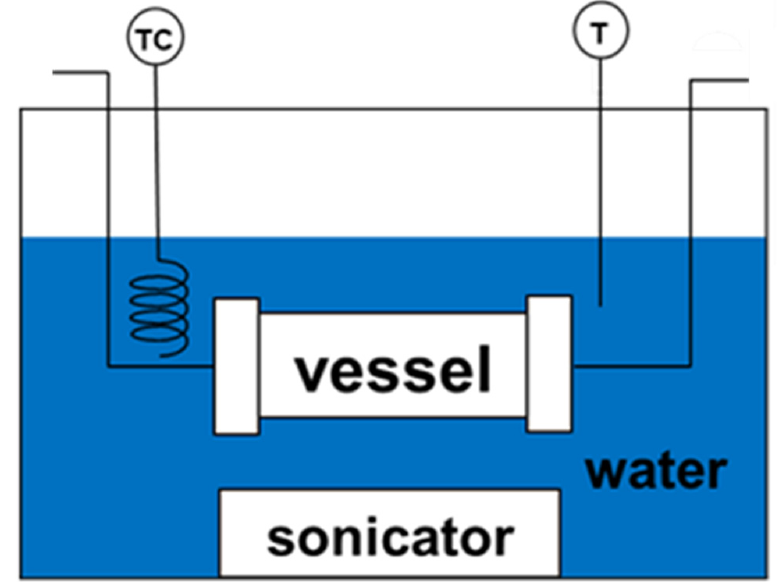
Figure 1. Ultrasonic irradiation apparatus for the synthesis of Ag NPs.